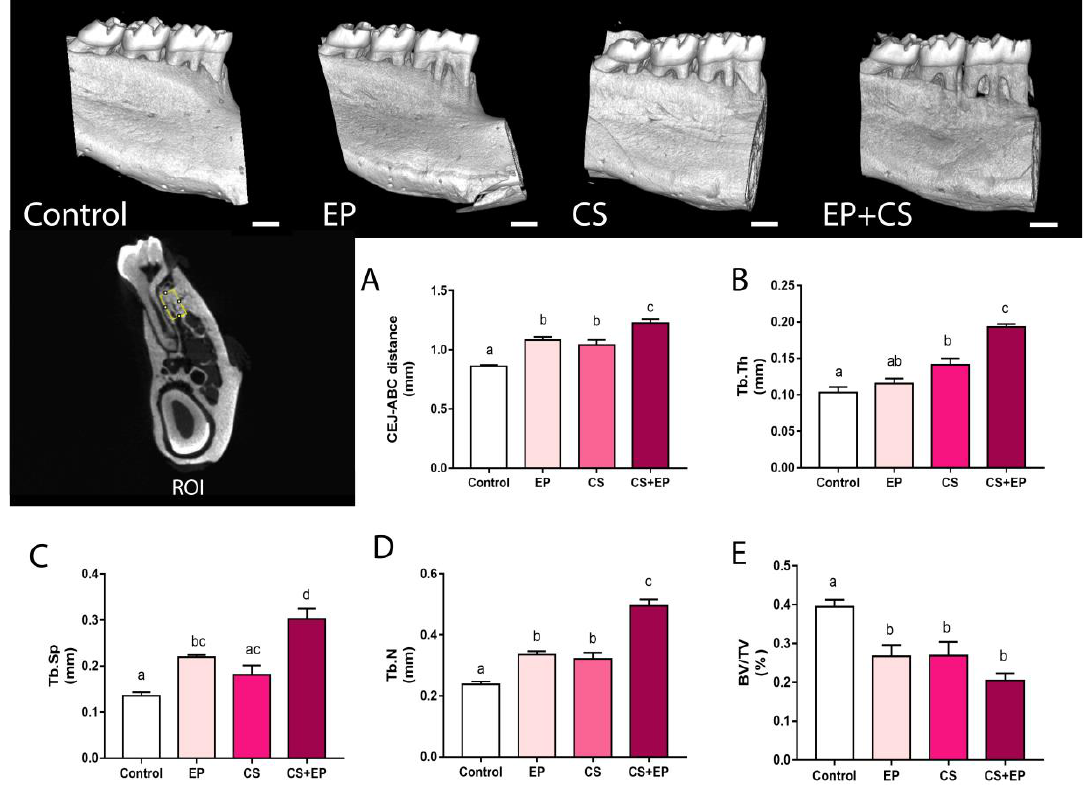
Figure 4. E ff ects of experimentally induced chronic immobilization stress and ligature-induced periodontitis on the quality of the alveolar bone of male Wistar rats (90-days-old, n = 28). Representative three-dimensional images of hemimandibles of the control group; experimental periodontitis group (EP); chronic stress group (CS); and chronic stress and periodontitis group (CS + EP). The representative image of the interradicular region, close to the furcation area, chosen to the standardized region of interest (ROI) for the analyses. Results are expressed as mean ± standard error for micro-CT parameters: ( A ) distance between the cemento-enamel junction (CEJ) and the alveolar bone crest (ABC) in millimeters (mm); ( B ) trabecular thickness (Tb.Th; mm); ( C ) trabecular spacing (Tb.Sp; mm); ( D ) mean number of trabecular per unit length (Tb.N); and ( E ) the percentage of bone volume in relation to the total measured area (BV / TV; %). One-way ANOVA and Tukey’s post-hoc test, p < 0.05. Similar overwritten letters did not reveal statistically significant di ff erences. Scale bar: 1